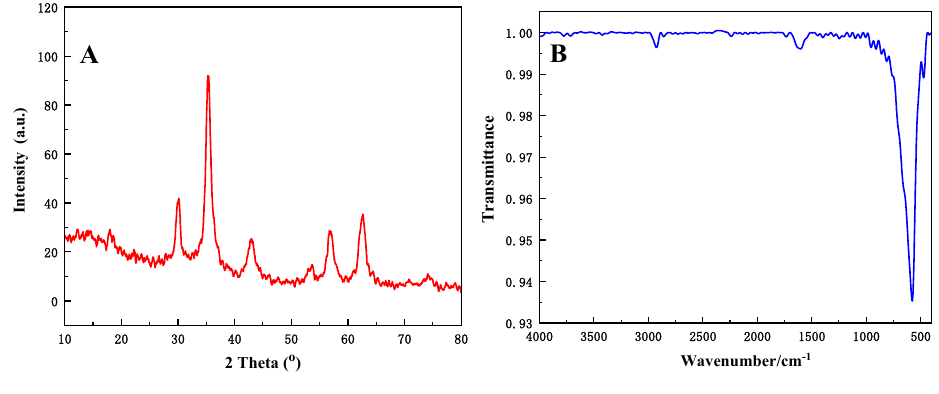
Figure 6. XRD ( A ) and FTIR ( B ) spectra of MC-4.